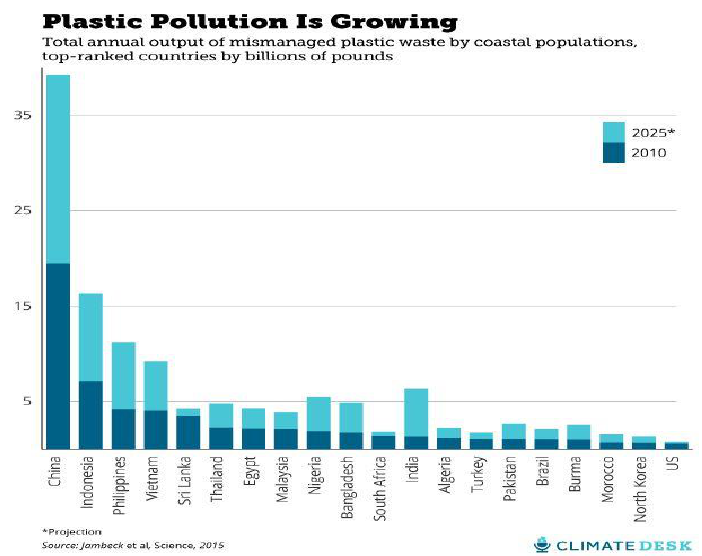
Figure 1. Plastic pollution is growing.